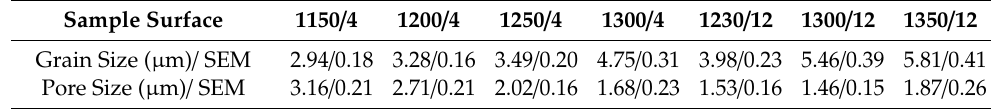
Table 2. Size, pore size and total porosity of samples sintered at di ff erent temperatures and